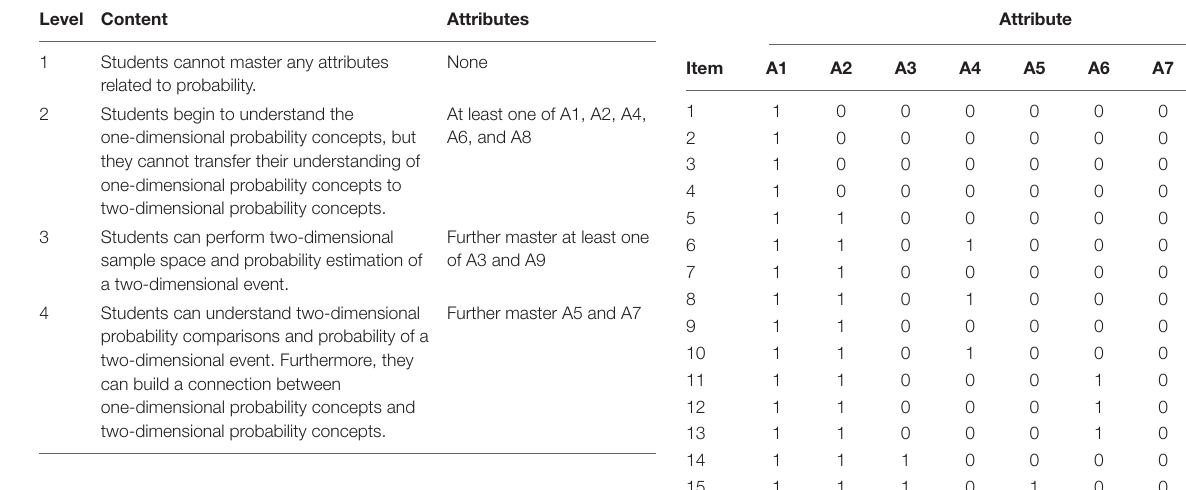
TABLE 1 | Hypothesized learning progression of probability. TABLE 2 | Q-matrix of attributes and